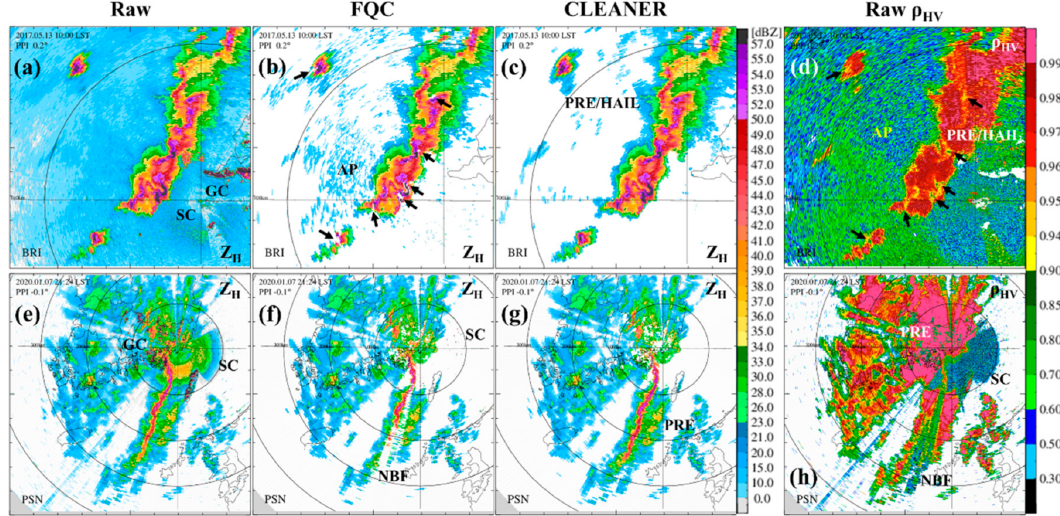
Figure 10. Reflectivity fields ( a , e ) before and after applying ( b , f ) the FQC algorithm and ( c , g ) CLEANER, and ( d , h ) correlation coe ffi cient fields for hail (top) and non-uniform beam filling (bottom) cases collected by BRI at an elevation angle of 0.2 ◦ at 1000 LST 13 May 2017 and by PSN at an elevation angle of –0.1 ◦ for a 480 km observational range at 2124 LST 7 January 2020,